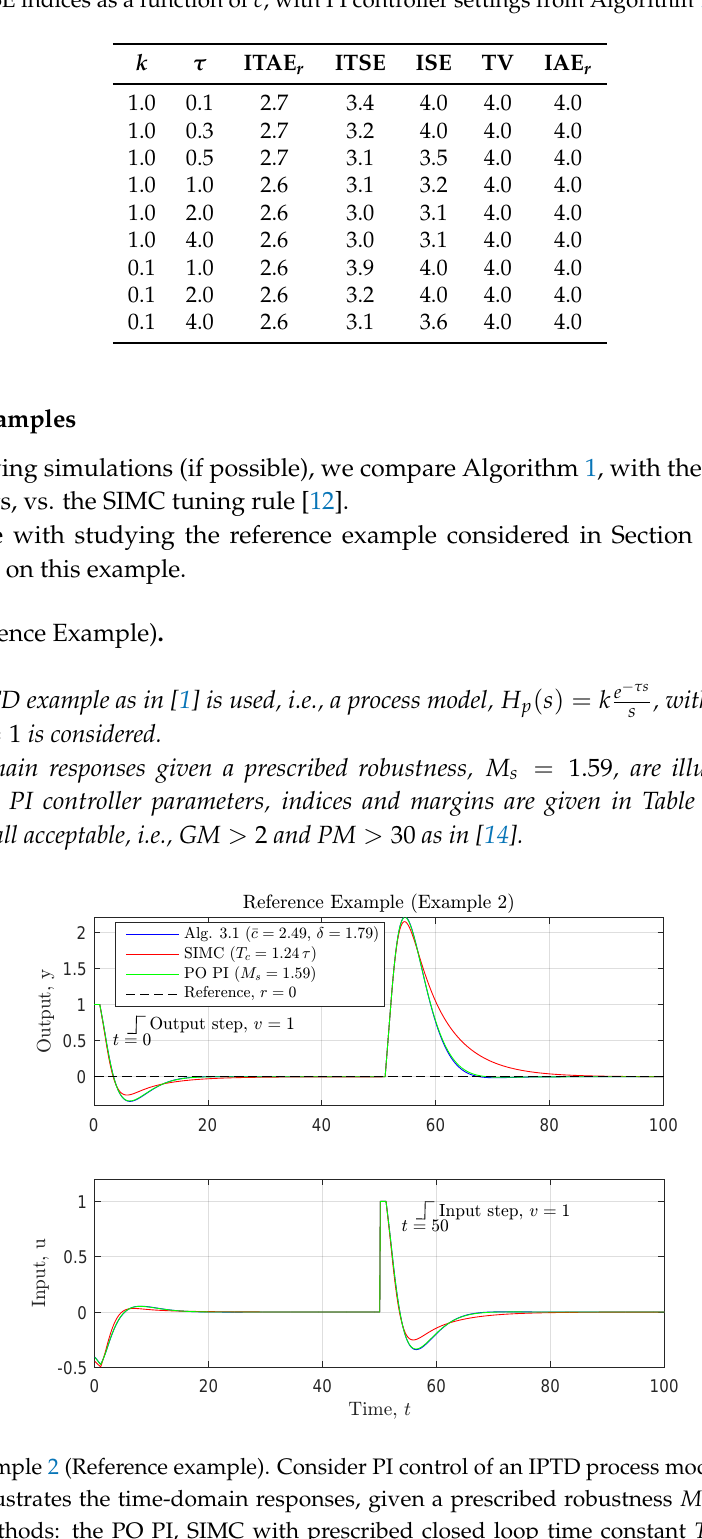
, with varying gain velocity, s M s , i.e., the minimum of IAE r , TV, ISE, ¯ c